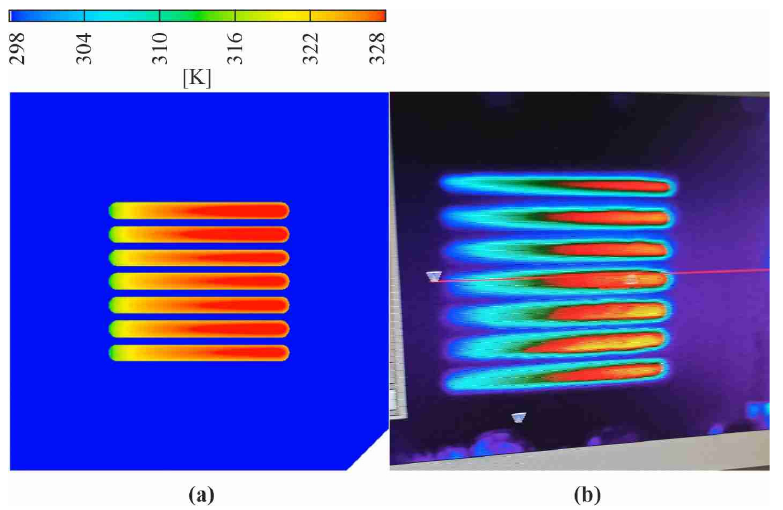
Figure 9. Two-dimensional temperature distribution on the heater surface obtained: ( a ) as the result of numerical computations due to Simcenter STAR-CCM+ software, ( b ) from the experiment with the use of an infrared camera.